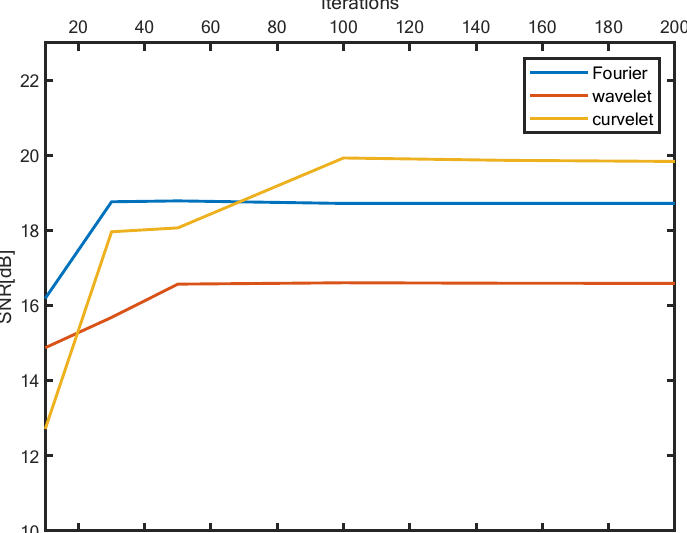
Figure 6. Comparison of convergence of SPGL1 algorithm in the sparse reconstruction of focusing functions, in which the red line is wavelet transform, the blue line is Fourier transform, and the yellow line is curvelet transform.